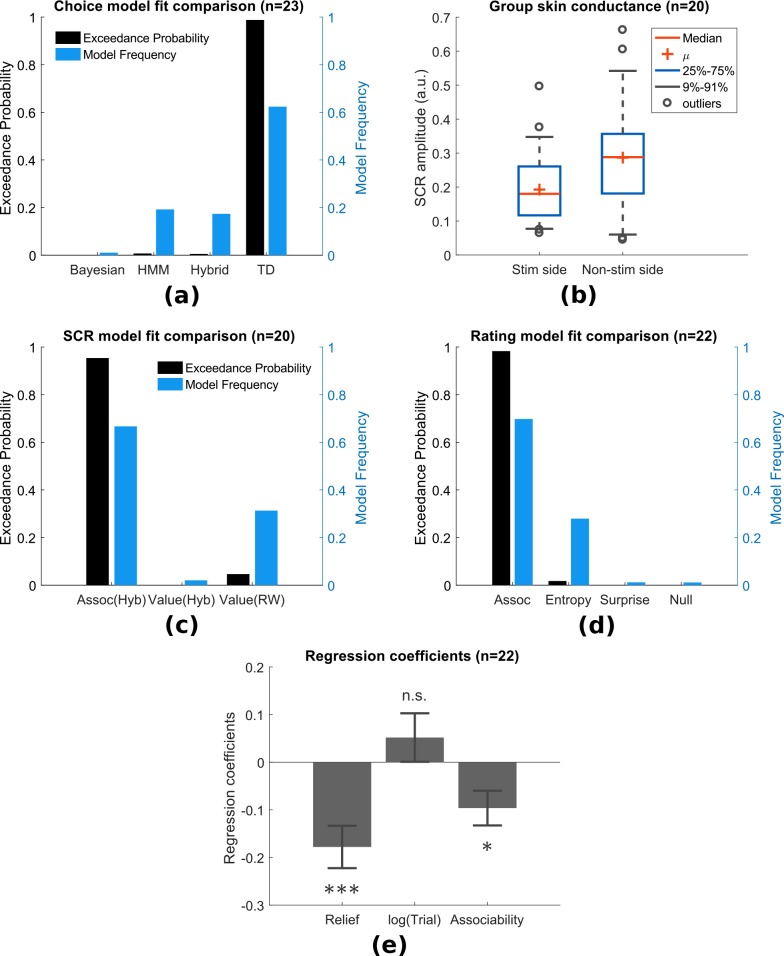
Experiment 2: behavioural results.(a) Model comparison showed that TD model fitted choices best (Bayesian: hierarchical Bayesian model, HMM: hidden Markov model, Hybrid: action-learning model with associability as changing learning rate). (b) SCRs measured on the side with thermal stimulation (‘Stim side’, left hand) were lower than those on without stimulation (‘Non-stim side’, right hand), but both were highly correlated. (c) Associability from state-learning hybrid model fit SCRs best, similarly to Experiment 1. (d) Trial-by-trial associability from hybrid model fitted pain ratings best compared with other uncertain measures (entropy: HMM entropy, surprise: TD model prediction error magnitude from previous trial, null model: regression with no predictors). (e) Regression coefficients with associability as uncertainty predictor were significantly negative across subjects.10.7554/eLife.31949.016Figure 4—source data 1.Experiment 2: behavioural data including SCRs, choices, ratings can be found in zip file attached.